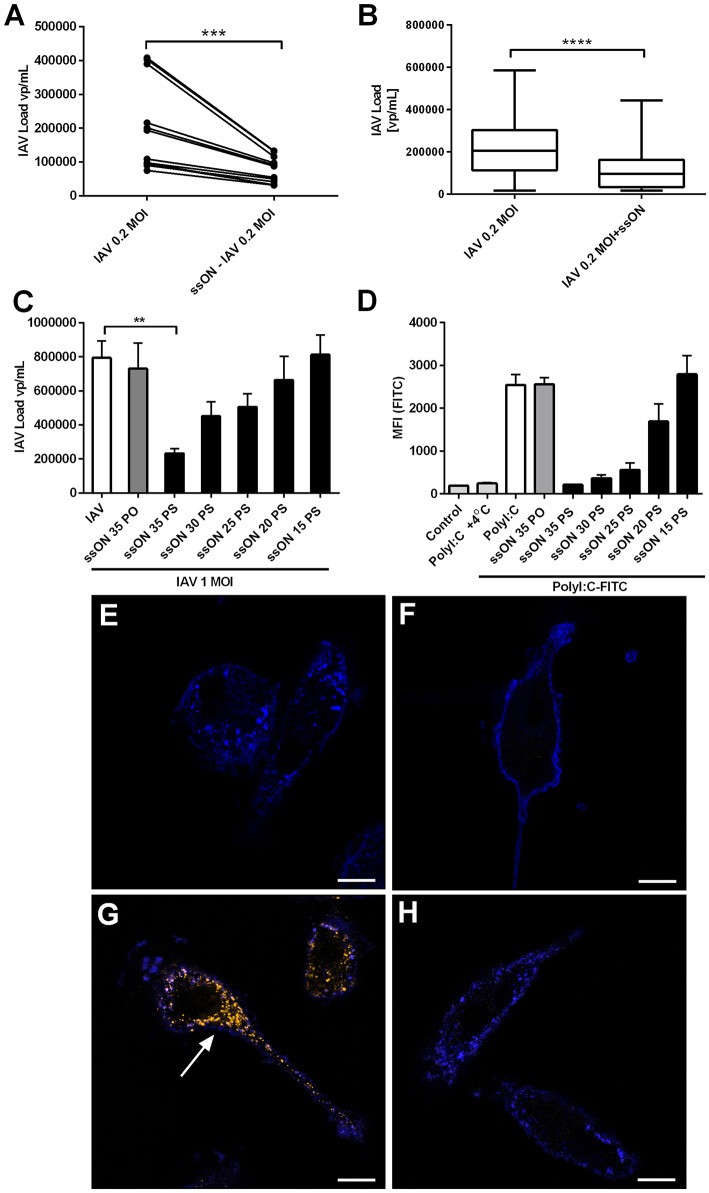
Decreased IAV content in supernatants of ssON treated MoDC cultures. (A) MoDC were treated with or without ssON during 2 h followed by IAV-infection at MOI of 0.2 for 2 h. IAV content was determined by qRT-PCR for the HA gene. Four individual donors were evaluated in triplicates. Wilcoxon paired two-tailed rank test was used ***P < 0.0005. (B) Treatment with ssON added 4 h after infection with IAV also showed a significant impact on the viral content detected in the supernatants. Data from 16 donors analyzed in triplicates. Wilcoxon paired two-tailed rank test was used ****P < 0.0001. (C) IAV content in supernatants at 24 h after infection with MOI of 1 in the absence (white bar) or presence of indicated ssON (sequences in M&M) with PO backbone or different lengths of PS ssON. Data from at least six samples **P ≤ 0.001. (D) MoDC were treated for 45 min at +37°C or +4°C with endocytic uptake markers PolyI:C-Alexa488 in the absence (white bar) or presence of indicated ssON with PO backbone or different lengths of PS ssON. Flow cytometry was used to quantify the fluorescent signal. Data from two donors run in duplicate. (E–H) Confocal microscopy of MoDC stained with a membrane marker, wheat germ agglutinin-Alexa633 (blue) and incubated for 45 min and kept (E) untreated, (F) with PolyI:C-Cy3 at 4°C, (G) PolyI:C-Cy3 at 37°C, and (H) PolyI:C-Cy3 at 37°C in the presence of ssON. Arrow points at uptake of PolyI:C-Cy3 (orange). Data representative of two donors. Scale bar 10 μM.